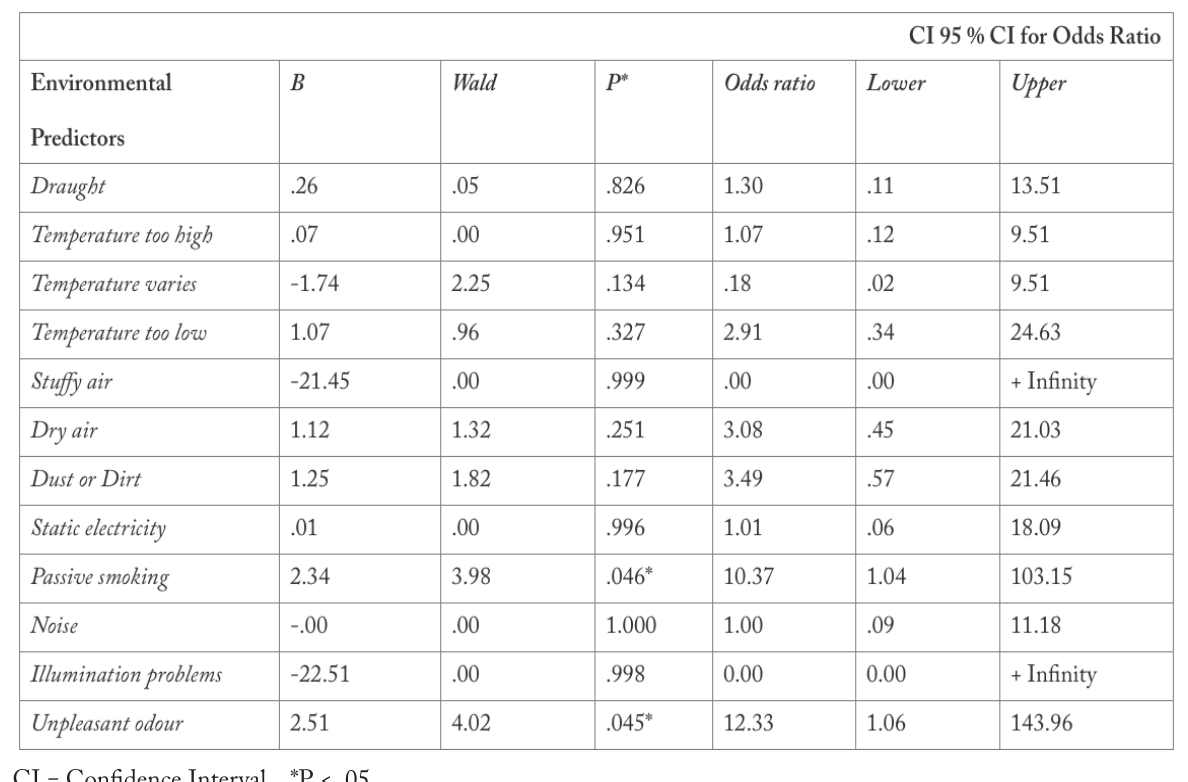
Table 4. Results of the logistic regression analysis with environmental parameters predicting cases of SBS among COs ( n